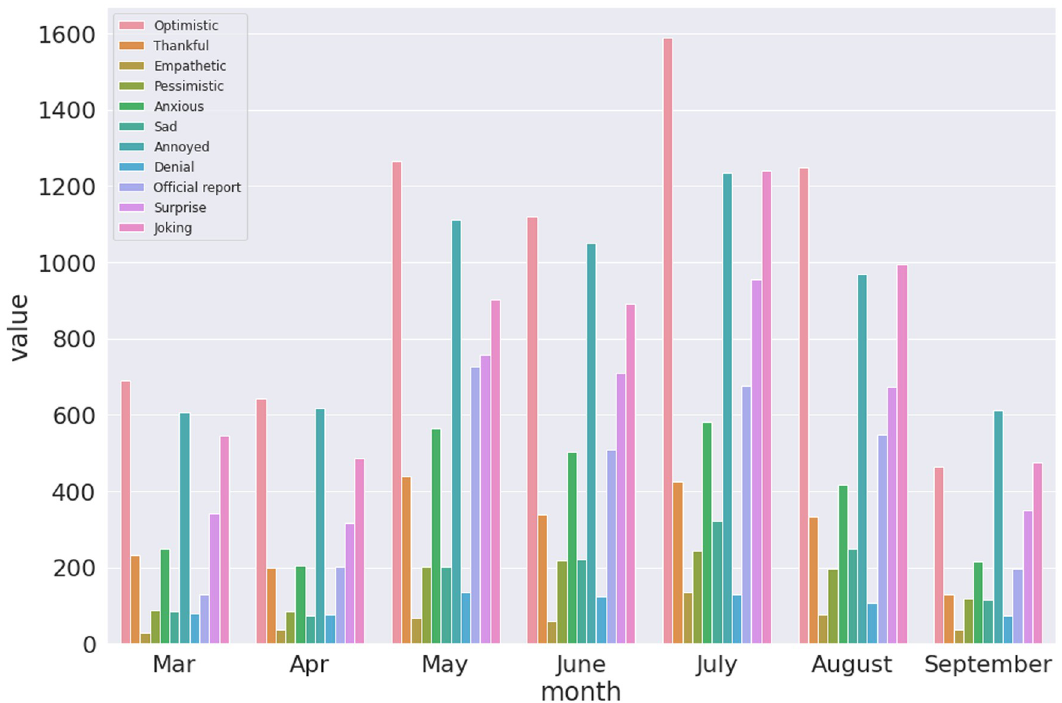
Fig 11. Monthly COVID-19 sentiments in Maharashtra using the BERT model.